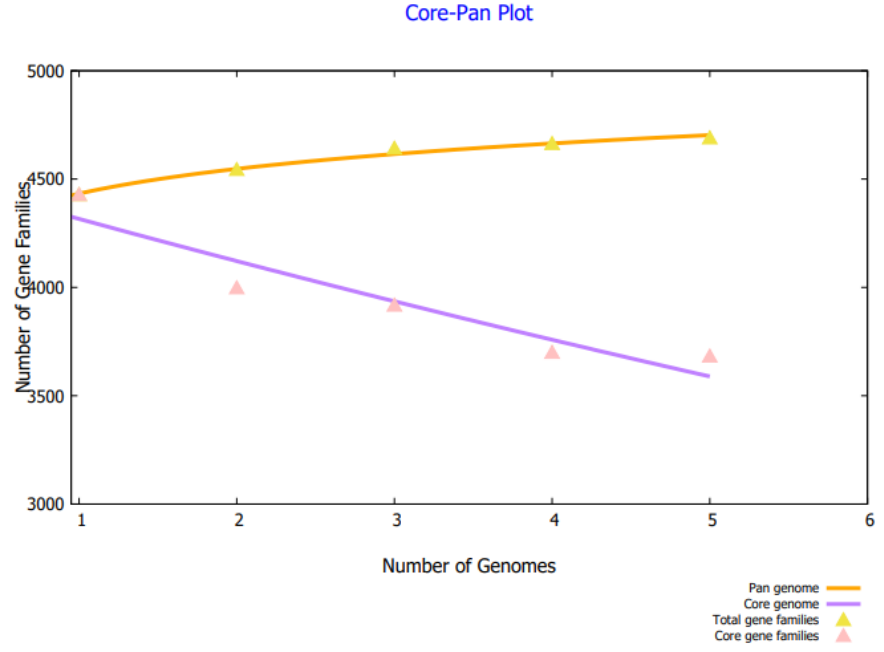
Figure 2. Core-pan plot illustrating the number of gene families in each genome. The pan and core gene families can be differentiated by different colors.